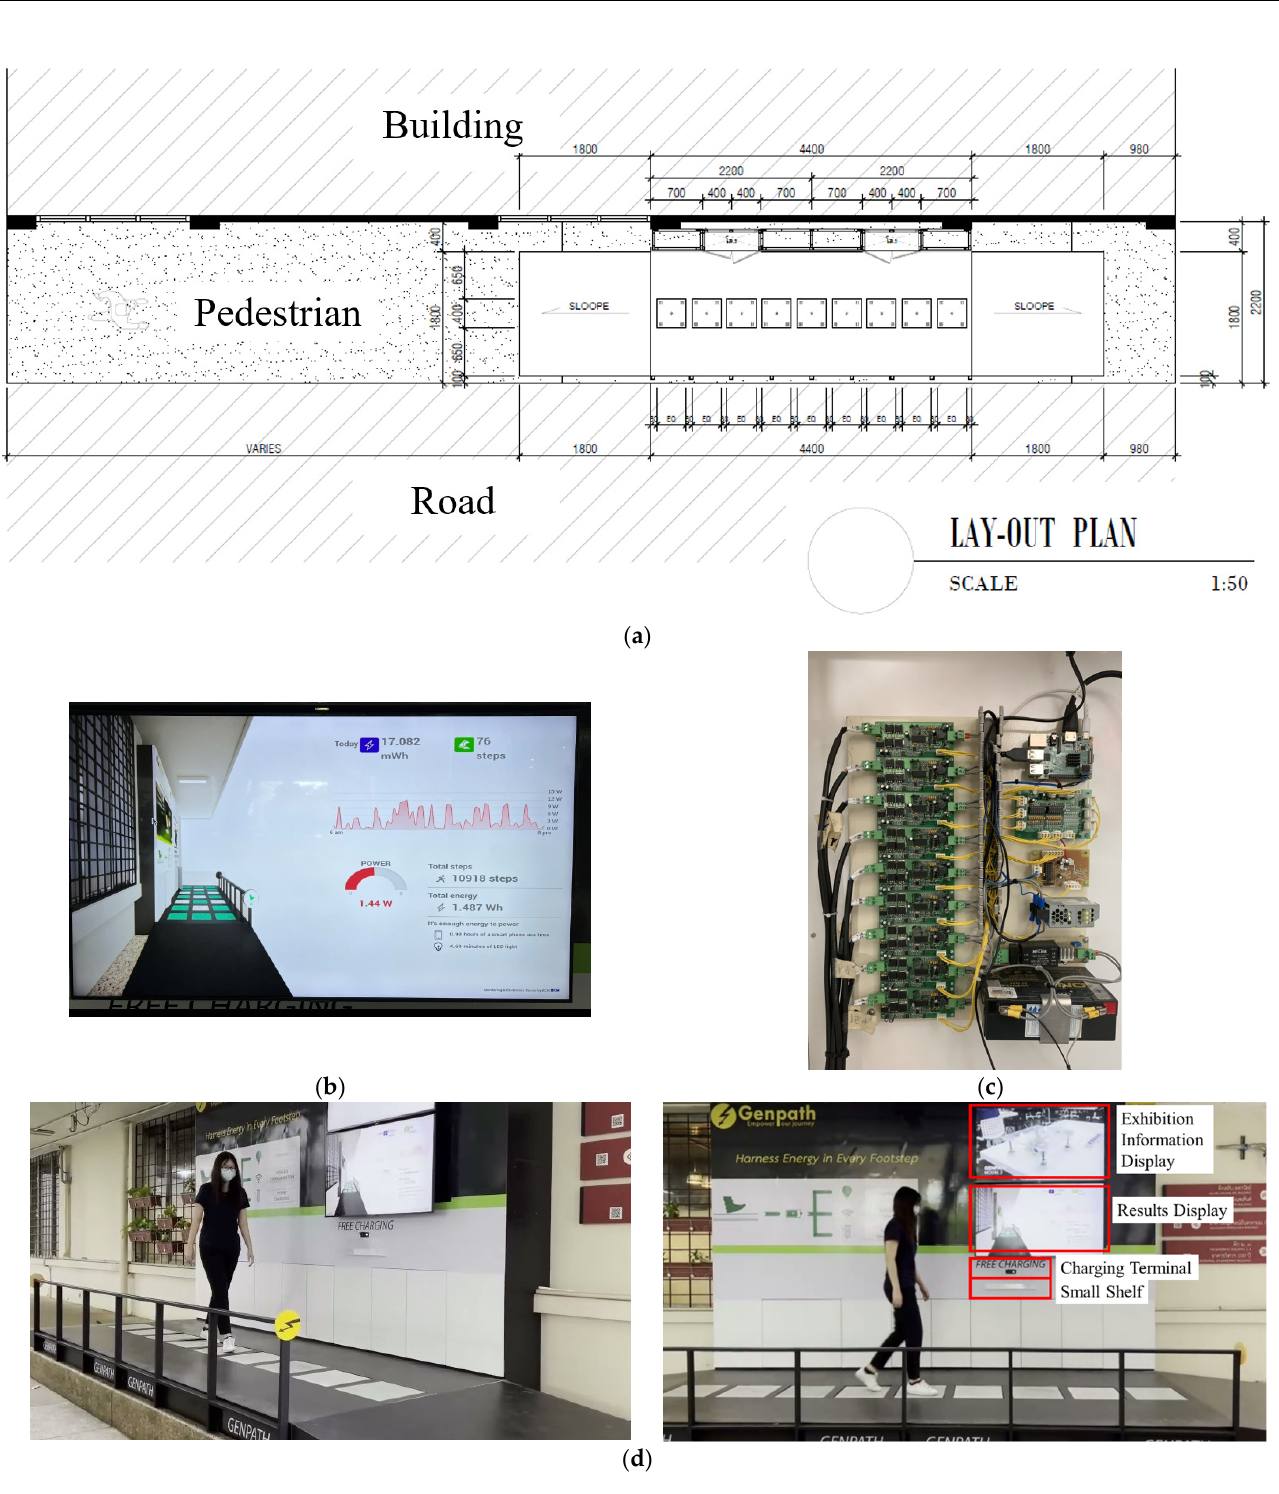
Figure 13. Genpath exhibition, “Genpath empower our journey”: ( a ) Genpath exhibition design drawing ( b ) energy result display ( c ) PMS for the exhibition walkway ( d ) Genpath exhibition walkway.